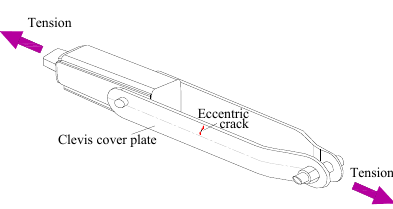
Figure 1. Off-central crack in a typical tension clamp. Figure 1. O ff -central crack in a typical tension